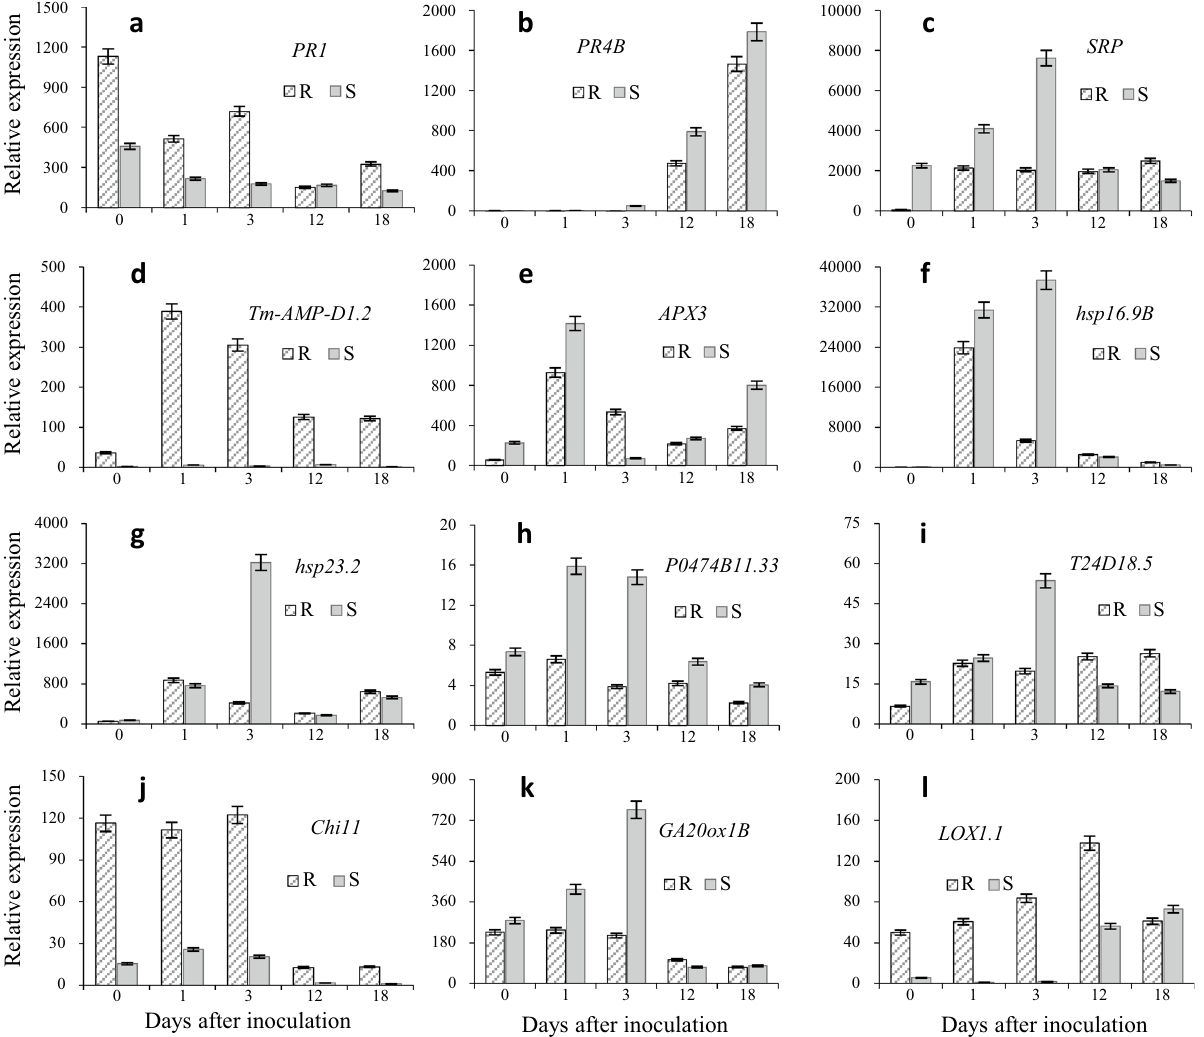
Figure 5. Spatiotemporal expression profiles of the twelve selected genes. ( a ) TraesCS2D01G317800 (pathogenesis-related protein 1); ( b ) TraesCS3D01G524700 (wheatwin-2, Precursor); ( c ) TraesCS2D01G114800 (stress-related protein); ( d ) TraesCS1A01G014000 (defensin Tm-AMP-D1.2); ( e ) TraesCS2A01G071700 (probable l-ascorbate peroxidase 3); ( f ) TraesCS3D01G045600 (16.9 kDa class I heat shock protein 2); ( g ) TraesCS2D01G311400 (23.2 kDa heat shock protein, Precursor); ( h ) TraesCS4D01G074600 (4-coumarate-CoA ligase-like 7); ( i ) TraesCS6D01G365700 (cinnamoyl-CoA reductase 1); ( j ) TraesCS5A01G500200 (chitinase 11, precursor); ( k ) TraesCS3B01G432800 (gibberellin 20 oxidase 1-B); ( l ) TraesCS4B01G037900 (linoleate 9S-lipoxygenase 1). The actin gene is used as internal control. The functional annotation and other details of A-L are listed in Table S9. All RT-qPCR reactions are replicated thrice. R and S are the slightly susceptible (SN4143) and highly susceptible (PZSCL6) line, respectively. Number 0, 1, 3, 6, 9, 12, 15, and 18 indicate the different days after